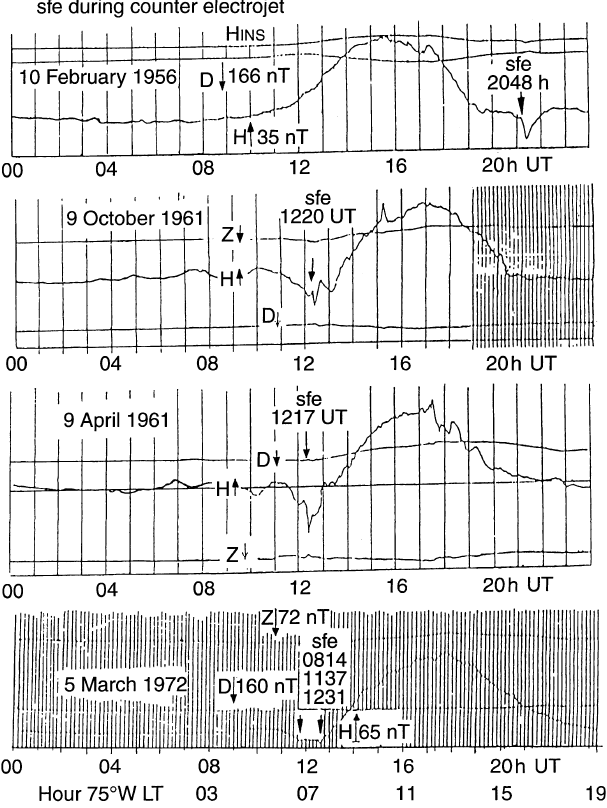
Fig. 13. Magnetograms at Huancayo showing solar flare e(cid:128)ects during counter